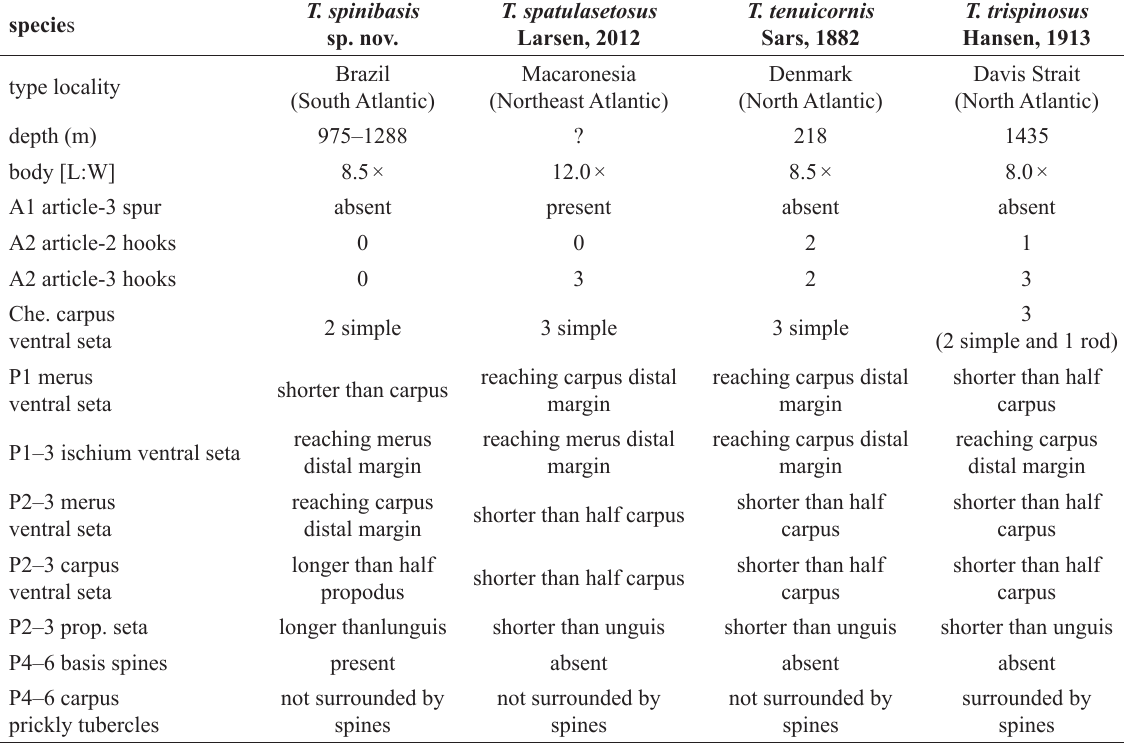
Table 5. Diagnostic characters of species of Typhlotanais ‘ trispinosus ’ group (based on females). Abbreviations: A1 = antennule; A2 = antenna; Che = cheliped; P = pereopod; Prop = propodus; ? = character state